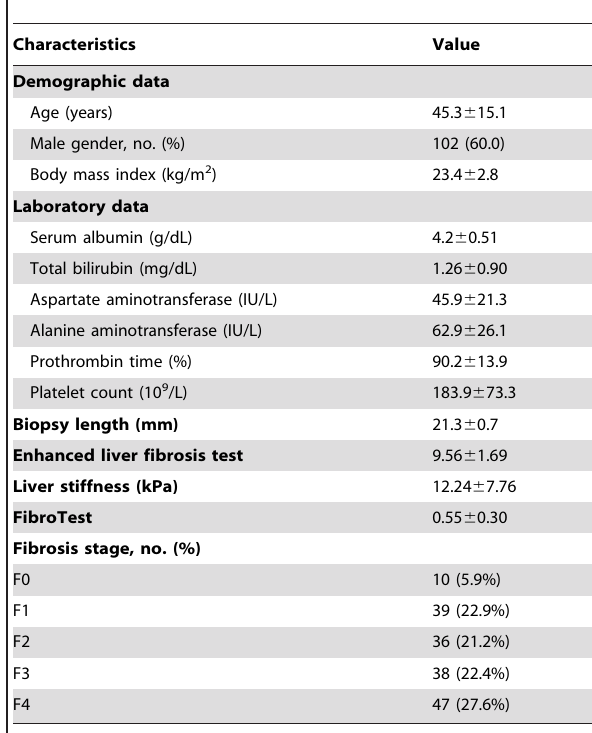
Table 1. Baseline characteristics (n=